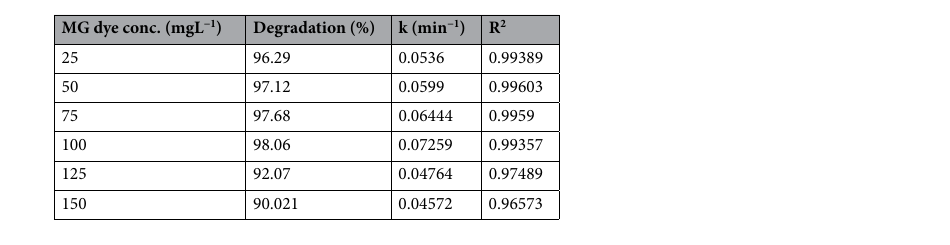
Table 3. Evaluation of various parameters for optimization for MG dye